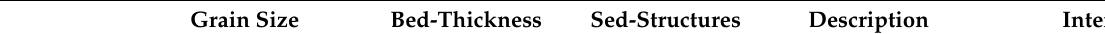
Table 1. Summary of sedimentary facies from the studied area (Pab